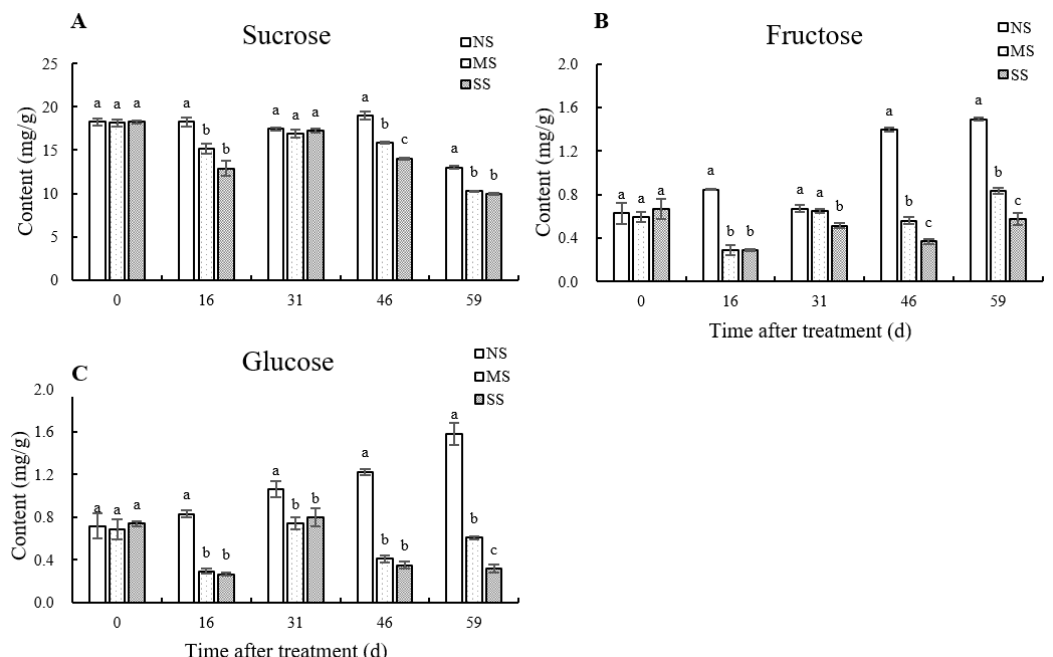
Figure 2. Dynamic changes in soluble sugar content in leaves. ( A ) Sucrose content. ( B ) Fructose content. ( C ) Glucose content. Values are means of three replicates ± SD and different letters indicate significant differences (Duncan ′ s multiple range tests, p < 0.05) among three treatments at the same developmental stage.